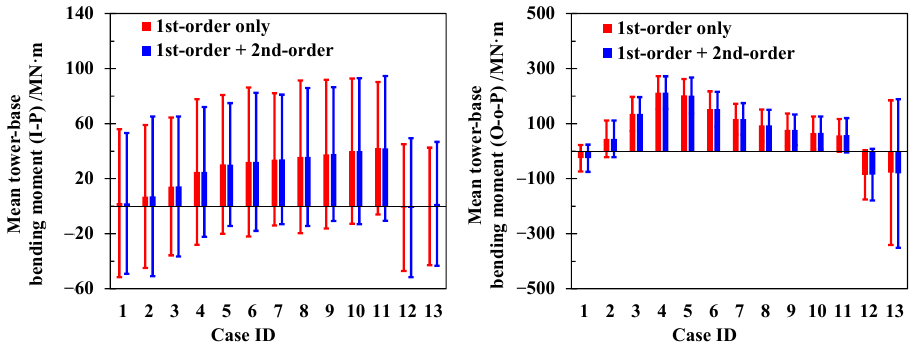
Figure 10. Mean values and standard deviations of the tower-base bending moment under all the examined load cases with and without considering the second-order wave excitations.